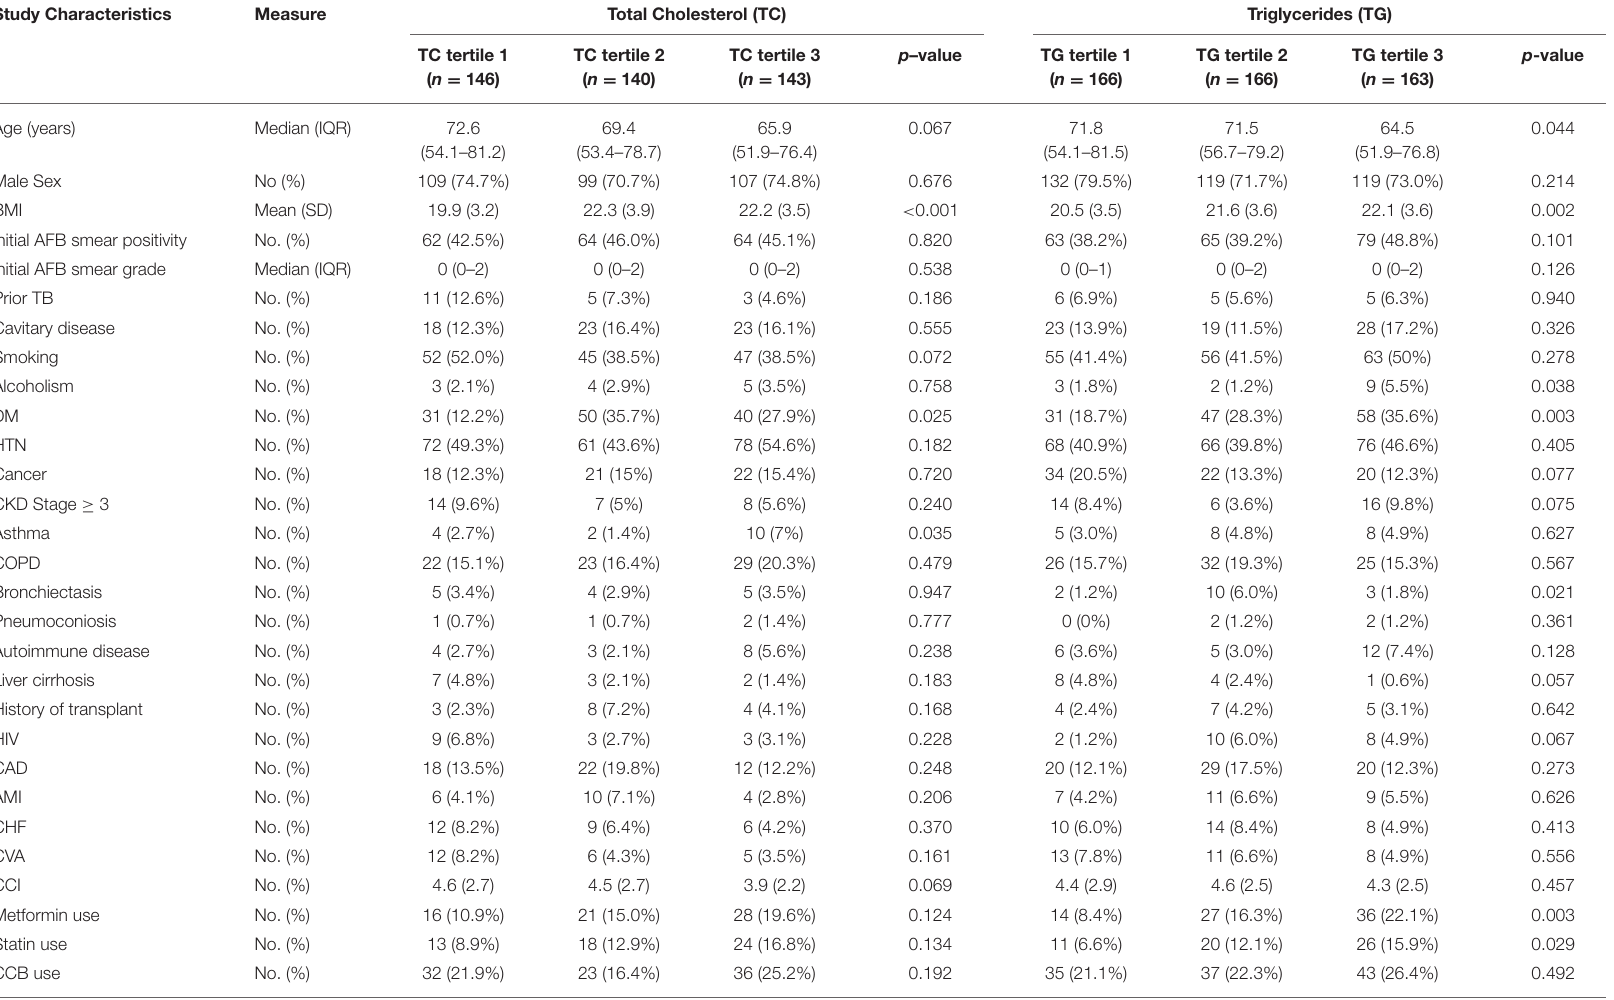
TABLE 2 | Patient Characteristics based on tertiles of baseline Total Cholesterol (TC) and Triglycerides (TG)